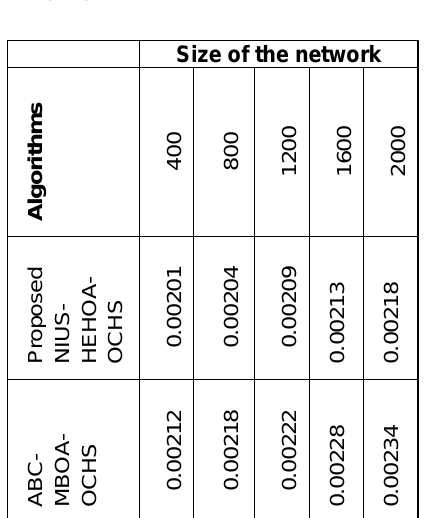
Table 4 . Mean End-to-End Delay for the proposed